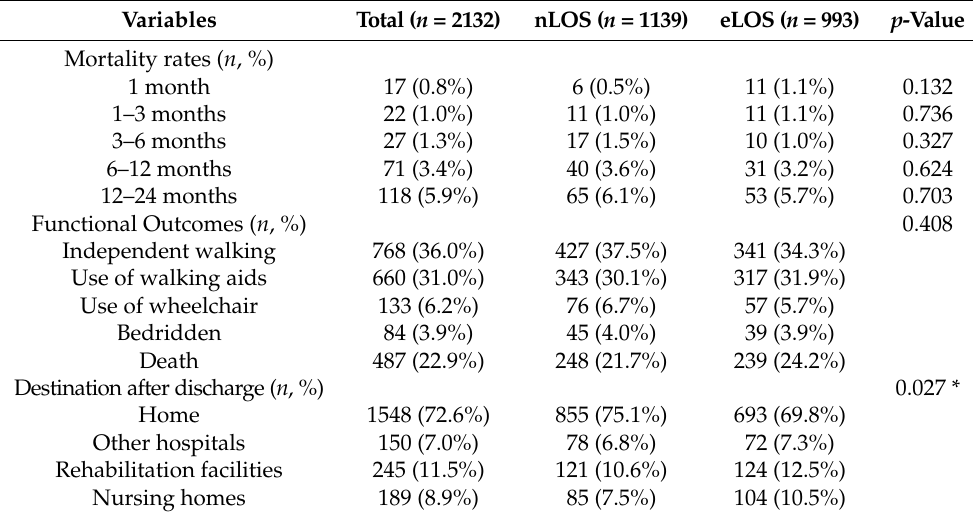
Table 2. Comparisons of the mortality rates, functional outcomes, and destination after discharge between the nLOS and eLOS groups.